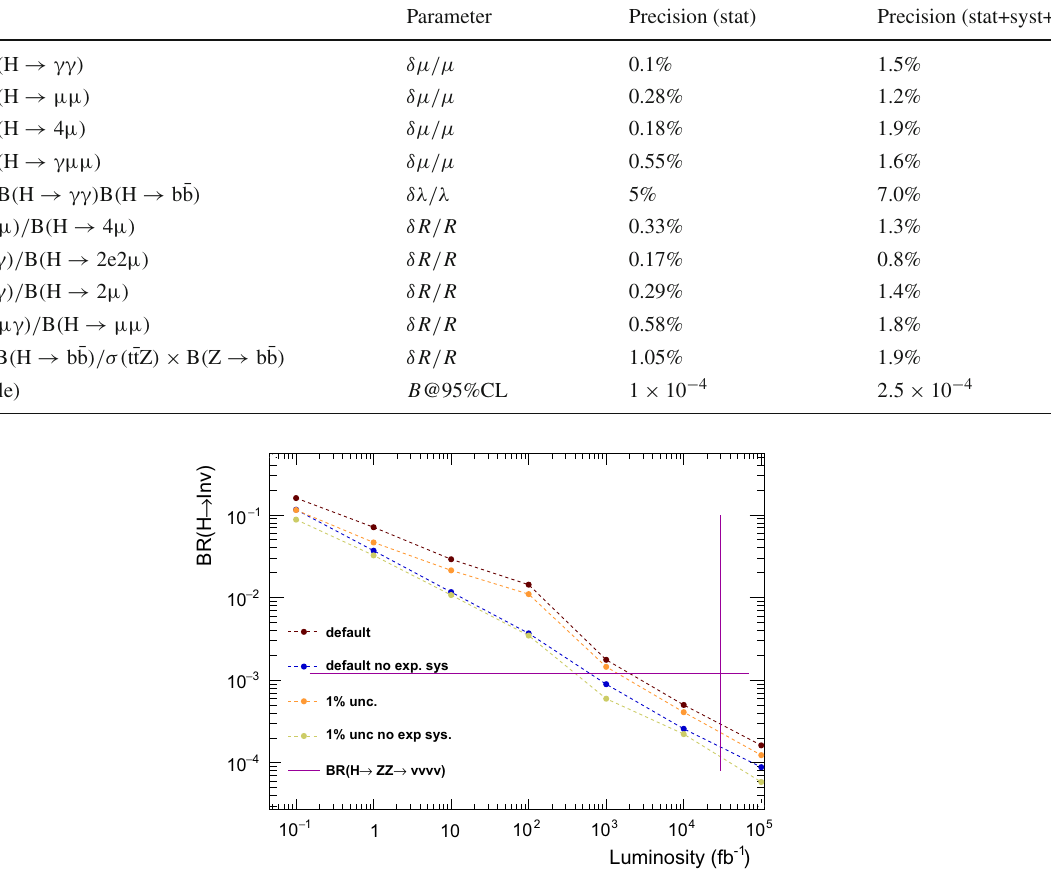
Fig. 4.7 Integrated luminosity evolution of the H → invisible branching ratio, under various systematics